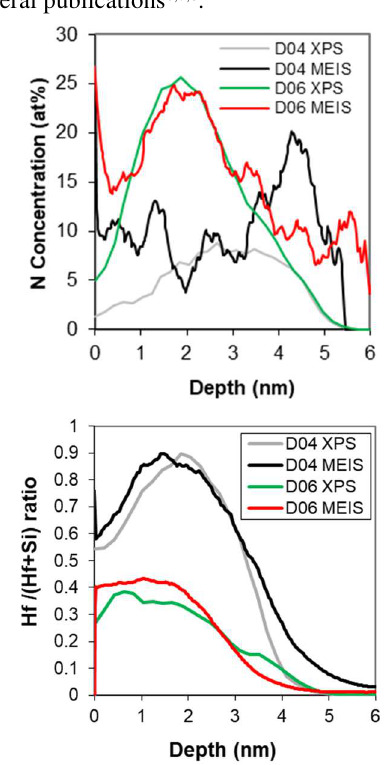
Figure 4 : ARXPS reconstructed composition profile of two nitrided HfSiO stacks.